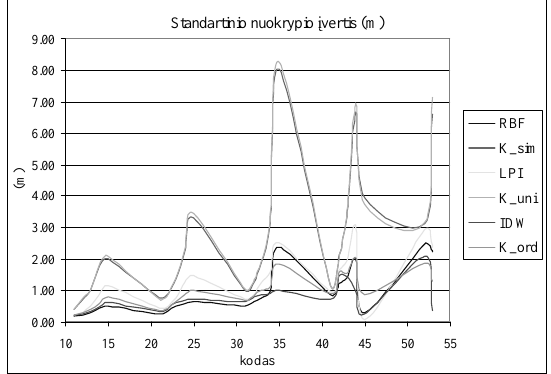
Fig 6. Distribution of DEM standard deviations in different relief categories Kadangi labai svarbu tiksliai į vertinti paviršiaus modeliavimo metod ų tikslum ą , SRM sudaryti naudojama daugiau kaip 1700 tašk ų , tarp kuri ų vidutinis atstumas yra 30 m, o daugiau kaip 3800 tašk ų aukš č i ų reikšmi ų yra naudojamos sudaryt ų reljefo modeli ų